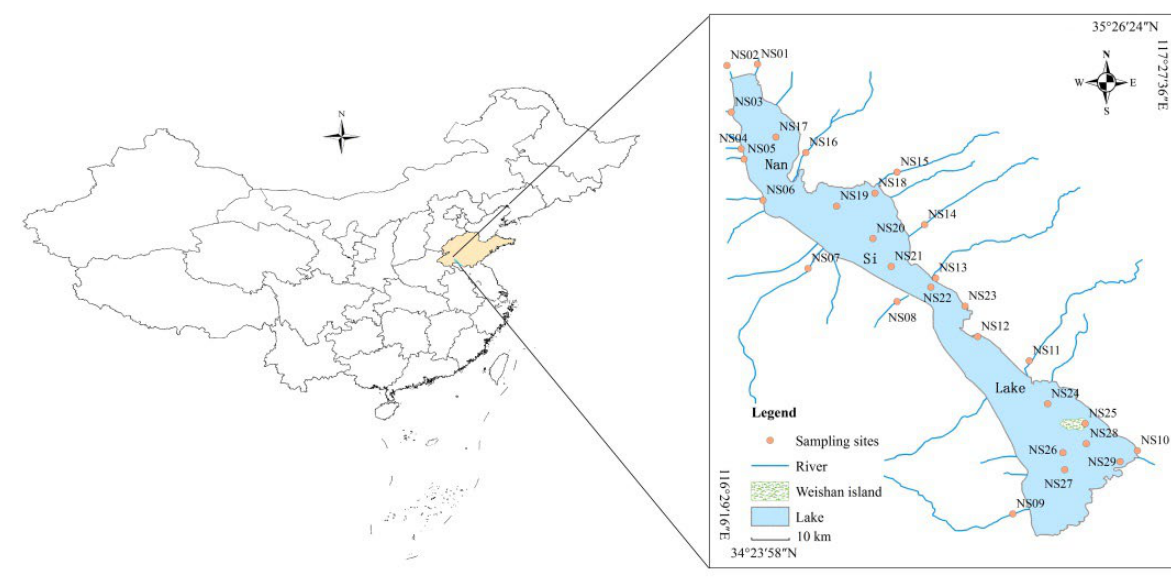
Figure 1. Sampling sites in the Nansi Lake basin.